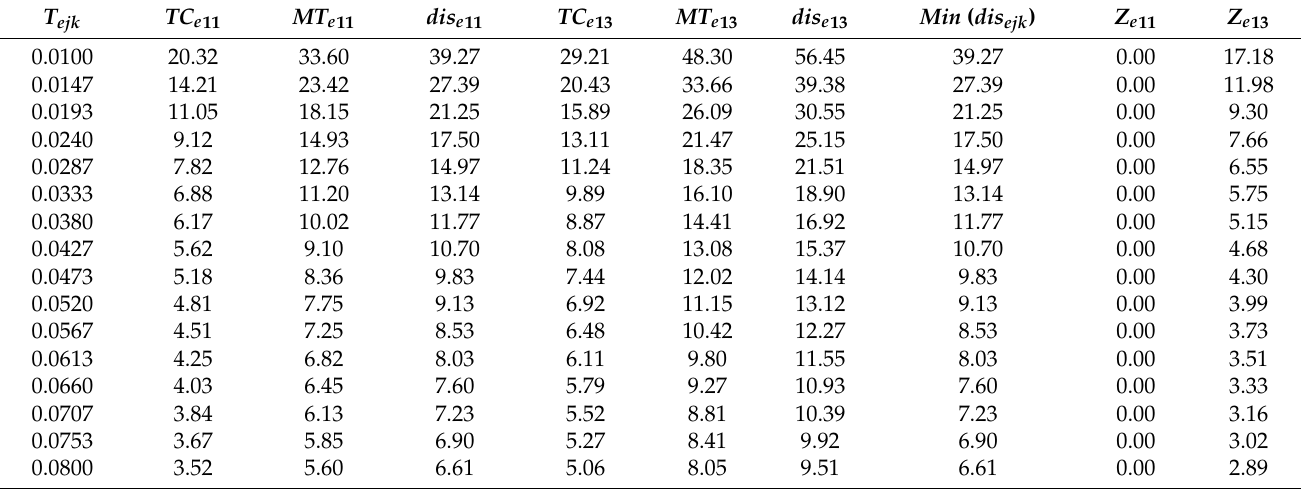
Figure 3. Possible processes and machines for each operation/sub-stage to manufacture WMA. Using Equations (2), (3), (10), (11) and (13), discrete tolerance ( td j ), tolerance ( t ejk ), tolerance cost ( TC ejk ), machining time ( MT ejk ), and distance values ( dis ejk ) are calculated for each machine and are shown in Table 1. Figure 4 is constructed for a discrete tolerance value of 0.01 mm ( t ejk = 0.01 mm), assuming TC ejk on the x -axis and MT ejk on the y axis. The distance between the origin and the discrete point of the machine represents the critical factor that decides on selecting the best machine. The value of less distance is more likely to be the best machine for the process. Table 1. Best machine for process number